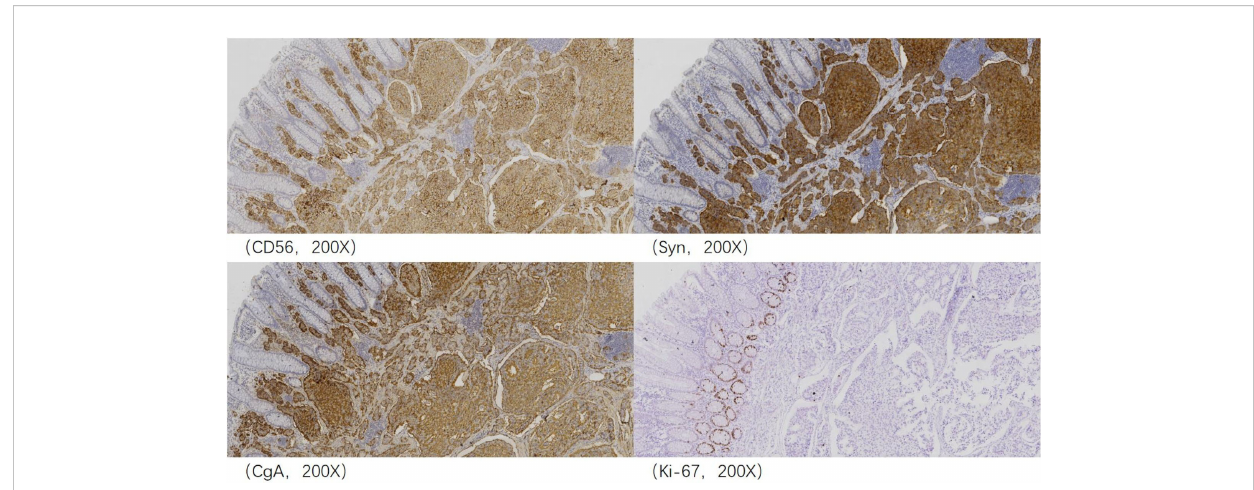
FIGURE 3 Immunohistochemical analysis revealed that the neuroendocrine component was positive for CD56, Syn, and CgA, and Ki-67 proliferation index was <2% and thus considered neuroendocrine tumor (NET) G1.